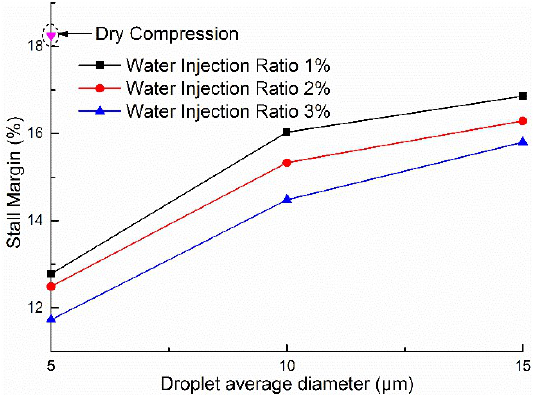
Figure 11. Comparison of the stall margin between dry and wet compression.